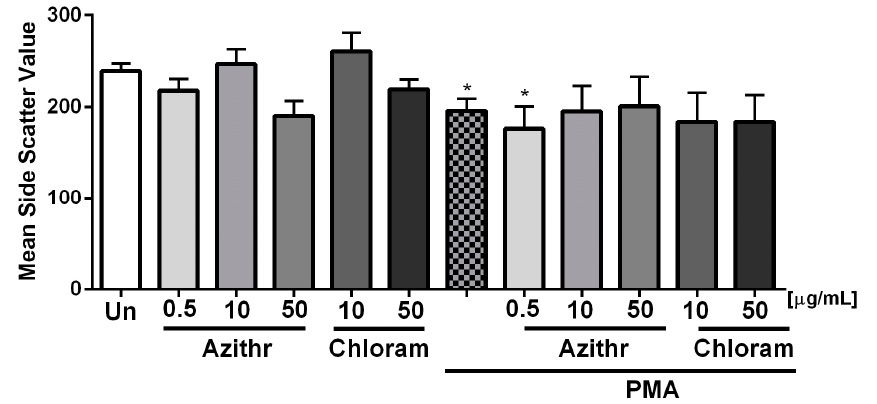
Figure 1. Effect of azithromycin and chloramphenicol on neutrophil degranulation assessed by measuring the granularity degree of neutrophils in the side scatter channel (SSC). 100 nM phorbol 12-myristate 13-acetate (PMA) was used as a positive control of degranulation ( n ≥ 3) (* p ≤ 0.05 vs . unstimulated (Un) cells).